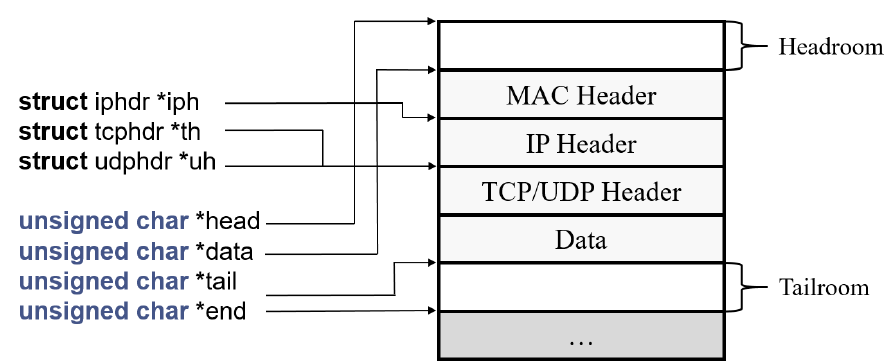
Figure 4. Pointers related to segment in